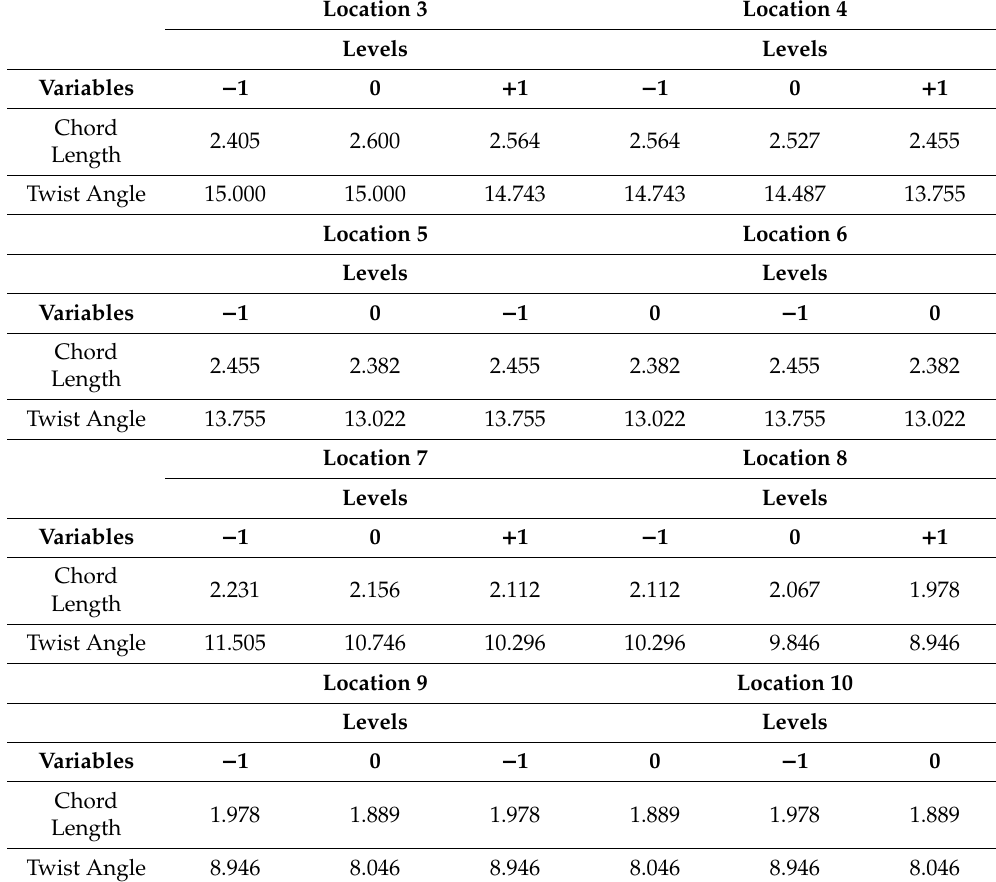
Figure 6. Calculation locations of the baseline blade for optimization. Table 3. Ranges and levels of variables, chord length (m), and twist angle ( ◦ Table 2. Baseline blade geometry and calculation location.